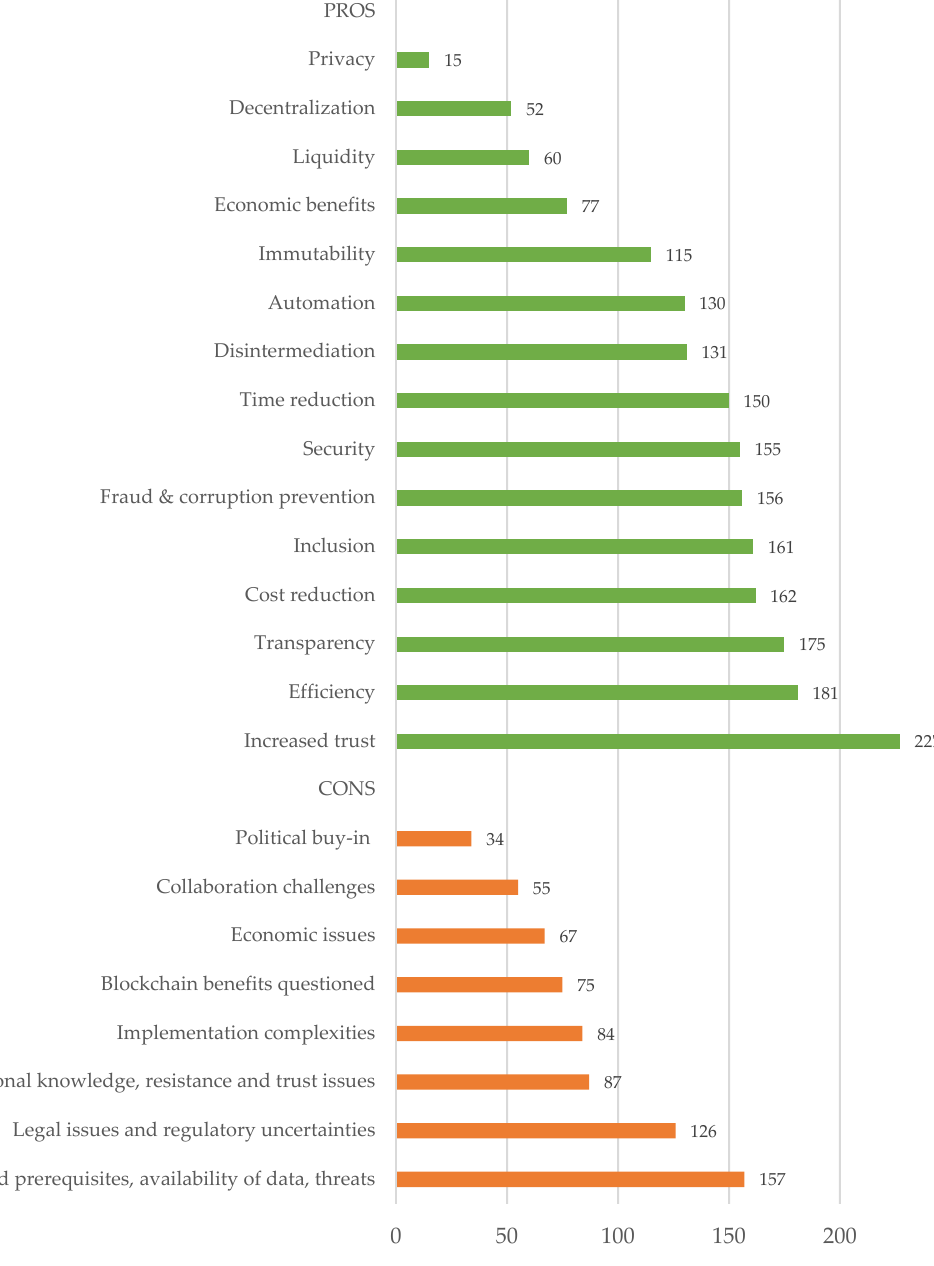
Figure 5. Theoretical blockchain pros and cons in the real estate sector. The number represents the number of documents.